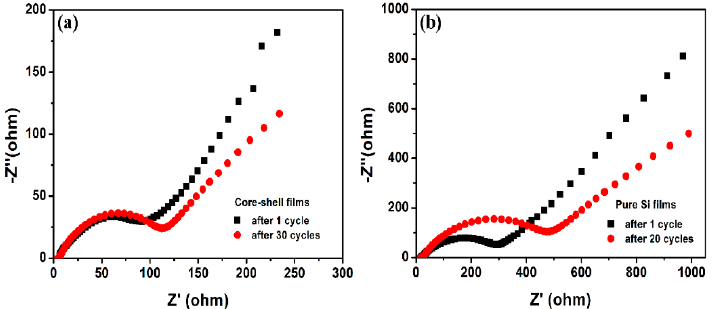
Figure 5. Electrochemical impedance spectroscopy spectra of ( a ) Cu@Si CSNWFs after 1 and 30 cycles; and ( b ) pure Si films after 1 and 20 cycles.